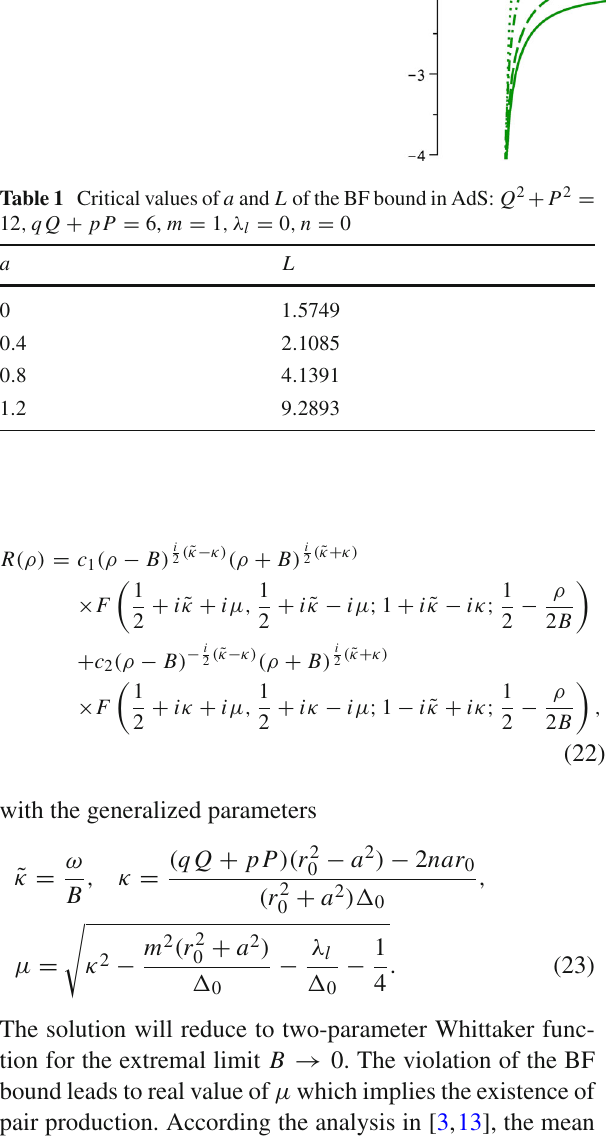
Fig. 5 The plot of BF bound + (cid:3) 0 m 2 for AdS (blue) eff 4 ( r 2 0 + a 2 ) and dS (green) with parameters Q 2 + P 2 = 12 , qQ + pP = 6 , m = 1 ,λ l = 0 , n = 0. The BF bound can be saturated, i.e. positive region, only in AdS